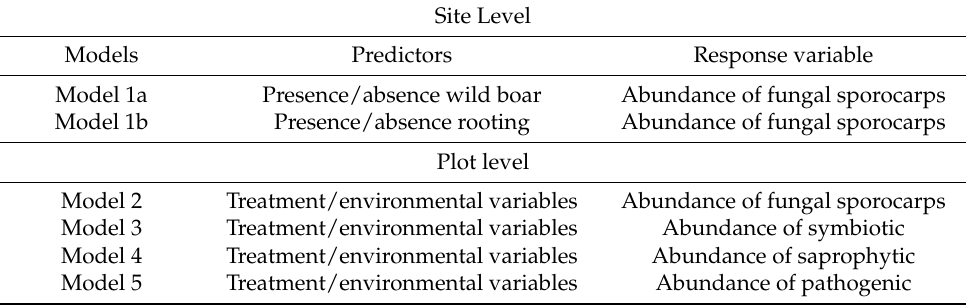
Table 1. List of developed models (at site and plot